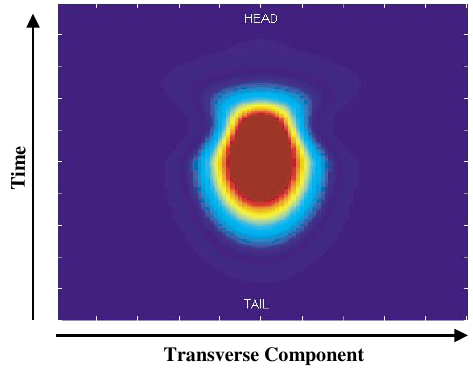
Table I for the typical beam and plasma parameters.